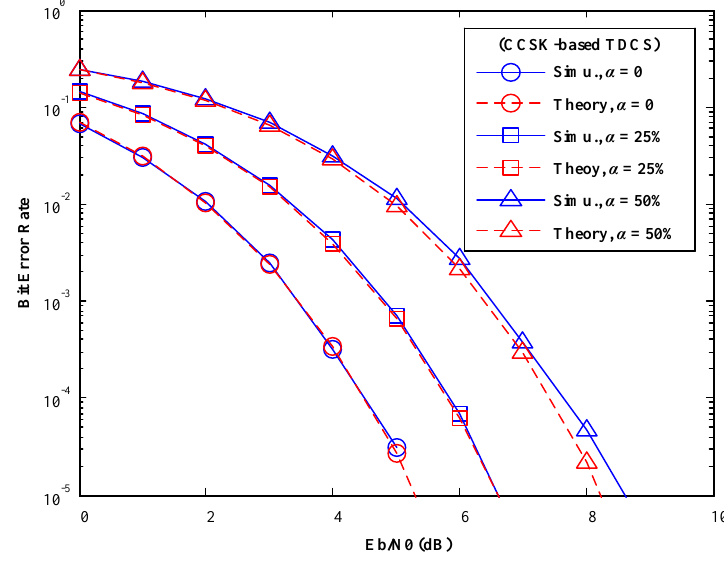
Figure 7. BER performance of TDCS-CCSK in AWGN channels (various mismatch factor α).